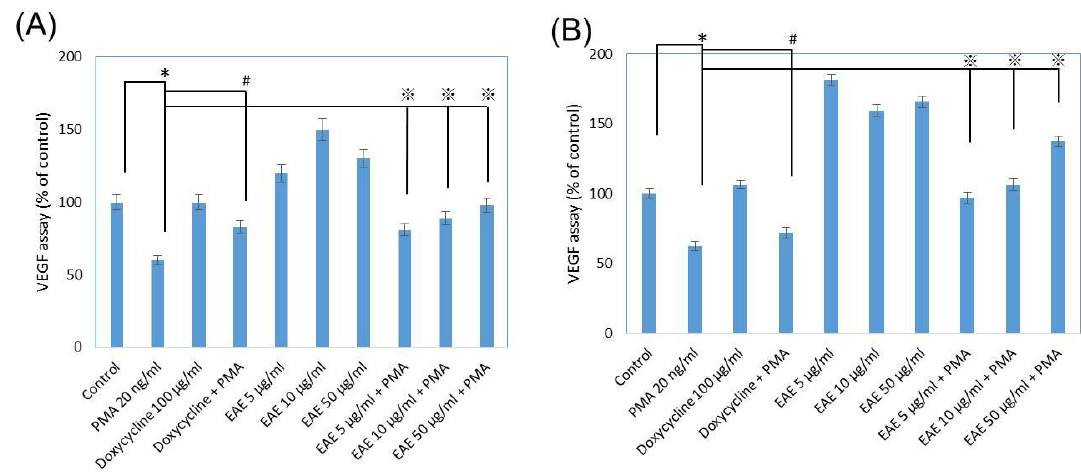
Figure 4. Human normal epidermal fibroblasts collagen production with EAE treatments in sirius red assay. In ( A ) Day 1, at 50 μ g/mL; ( B ) Day 7, at 50 μ g/mL; and ( C ) PMA, at 20 ng/mL treated 24 h. Sirius emitted bright red color (microscopy, the magnification is 100×); ( D ) Day 1 and ( E ) Day 7 have been quantitative; ( F ) Anti-oxidative effect of EAE in PMA-activated fibroblast viability. (Data represents mean ± S.D. of three independent experiments performed. * p < 0.01, # p < 0.01 and ※ p < 0.01).